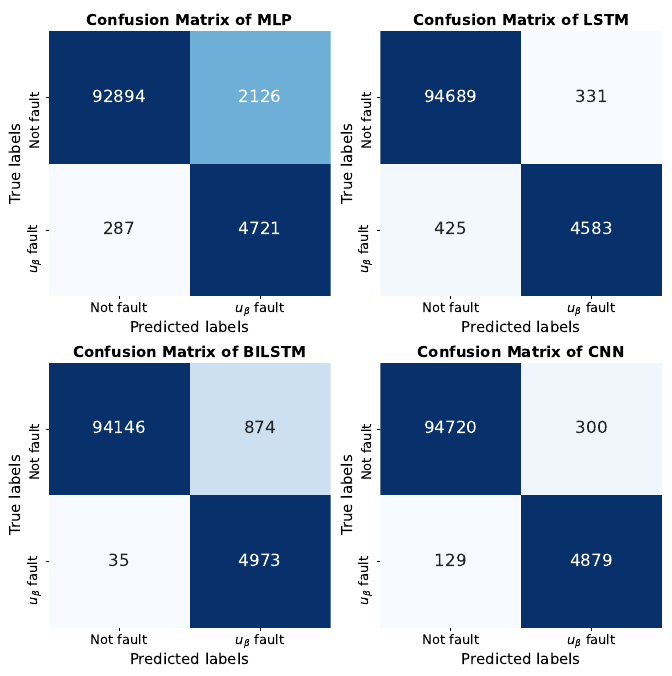
Figure 18. Confusion matrix plot for Channel 5 with 10-d delayed